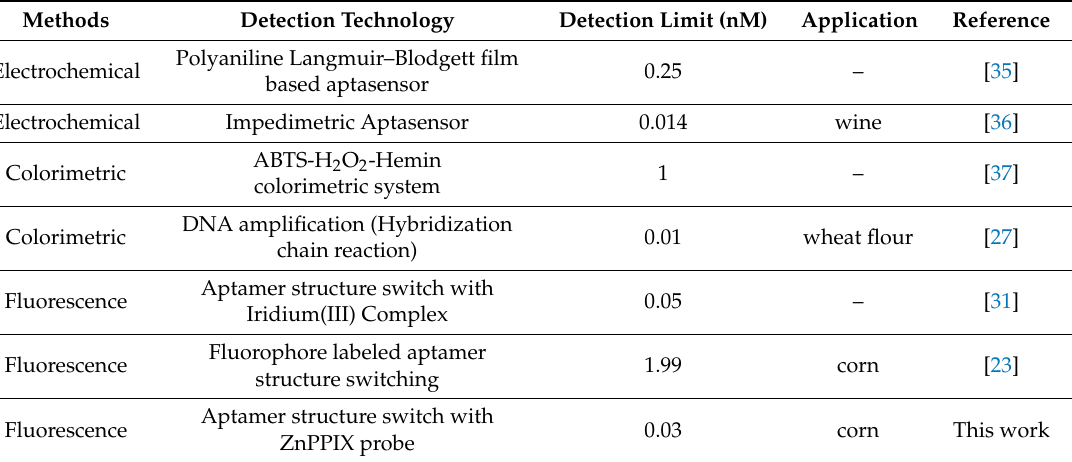
Figure 4. ( A ) Emission spectra of the assay system with different concentrations of OTA from 0~4 Nm; ( B ) The relationship between fluorescent intensity and OTA concentration. Inset: linear plot of fluorescent intensity vs. OTA concentration. Error bars show the standard deviations of three independent measurements ( λ ex = 430 nm). Table 1. Comparison of the properties of various OTA